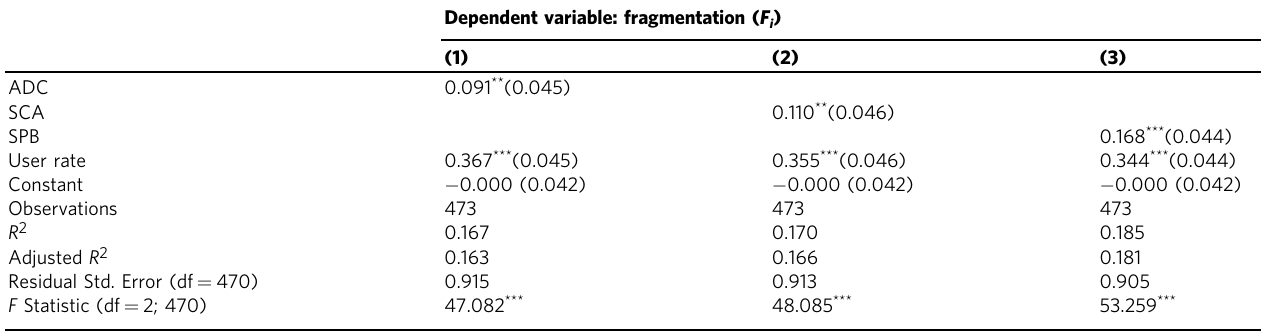
Table 1 We estimate the relationship between urban topology indicators and social network fragmentation using Eq. (4).